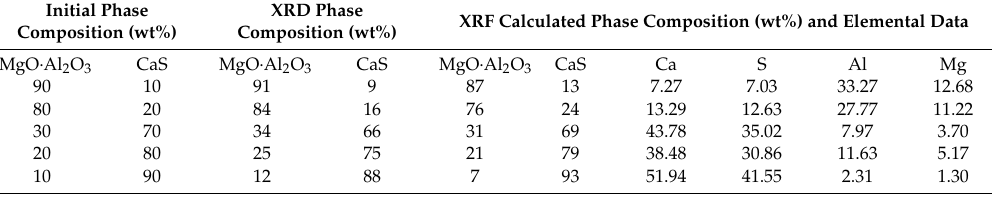
Figure 2. XRD spectra for the binary sample of CaS-Al 2 O 3 : ( i ) 20% of CaS, ( ii ) 60% of CaS, and ( iii ) 80% of the CaS phase component. Table 1. Initial sample composition, XRD and XRF analyses for binary calcium sulphide-aluminate spinel phases of MgO·Al 2 O3 (MA)–CaS.